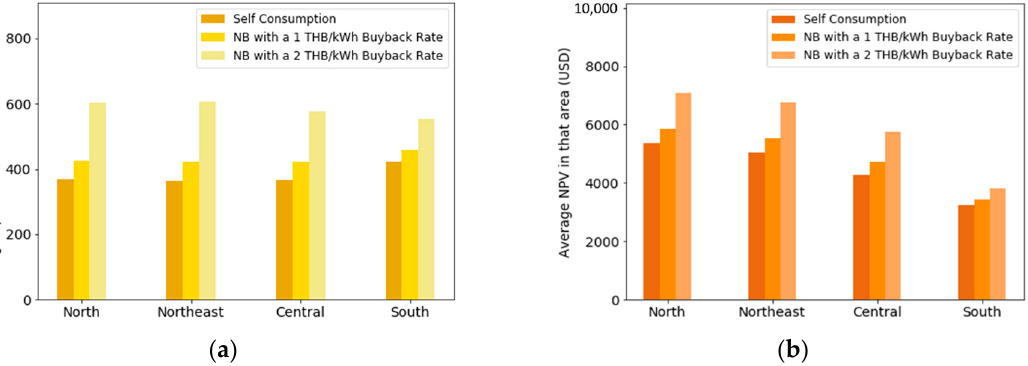
Figure 10. Comparison of ( a ) average optimal PV size and ( b ) NPV by region for MGS customers. (Note: The average optimal PV size and the average NPV are the average values among all provinces within a